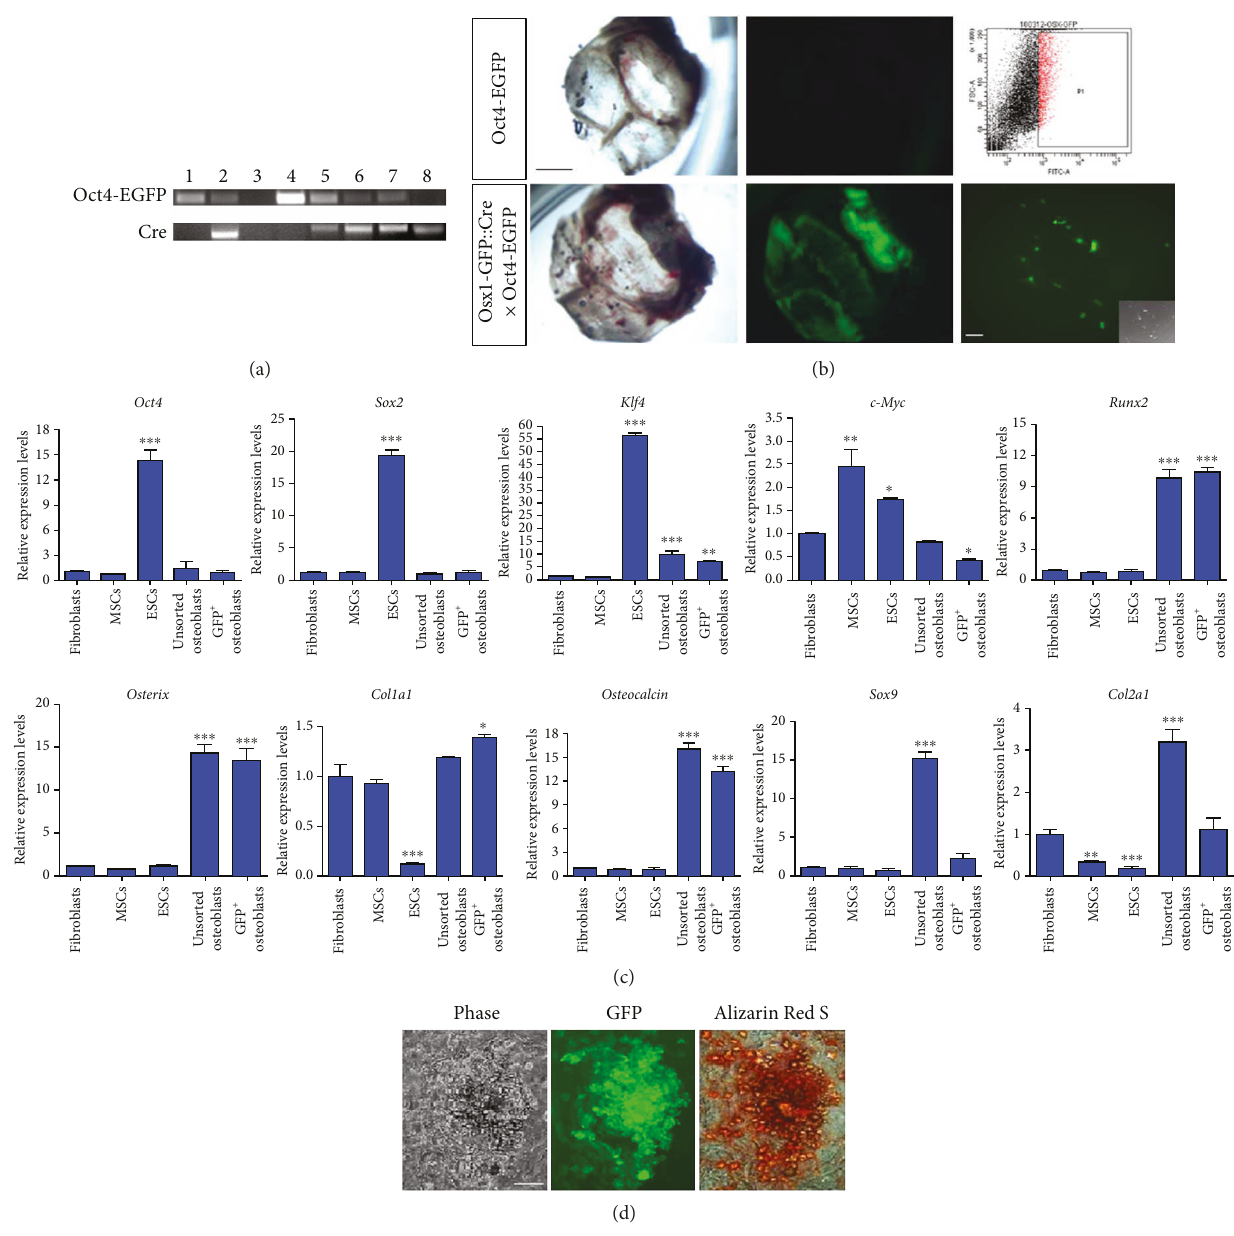
Figure 1: Isolation and characterization of calvaria-derived osteoblasts from newborn mice carrying both Osx1-Cre::GFP and Oct4-EGFP transgenes. (a) Genotyping analysis of 8 neonatal mice carrying Osx1-GFP::Cre and Oct4-EGFP transgenes for coding regions of Oct4- EGFP and Cre . (b) Bright fi eld images of the newborn calvaria. No GFP expression was detected in Oct4-EGFP calvaria, whereas GFP expression was observed in calvaria isolated from a transgenic mouse carrying both Osx1-GFP::Cre and Oct4-EGFP . Representative FACS plot of isolating osteoblasts expressing GFP from calvarial bone. Sorted osteoblasts express GFP in culture. Inset shows phase image of sorted osteoblasts. Scale bars: 20 μ m for calvarial bone; 5 μ m for GFP + cells. (c) qPCR analysis of the indicated transcript levels in MSCs, ESCs, unsorted osteoblasts, and sorted GFP + osteoblasts. Individual mRNA expression levels were normalized to Gapdh with fold change relative to dermal fi broblasts, which is arbitrary set to 1. (d) From left to right: phase image of sorted osteoblasts. GFP + osteoblasts were positive for Alizarin Red S staining. Scale bar: 20 μ m. Three independent experiments are represented in (c). Data are expressed as means ± SEM. ∗ p < 0 05 ; ∗∗ p < 0 01 ; ∗∗∗ p < 0 001